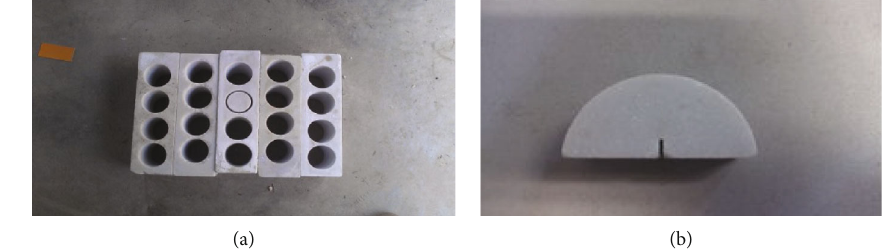
Figure 1: (a) Cored rock and (b) SCB specimen.